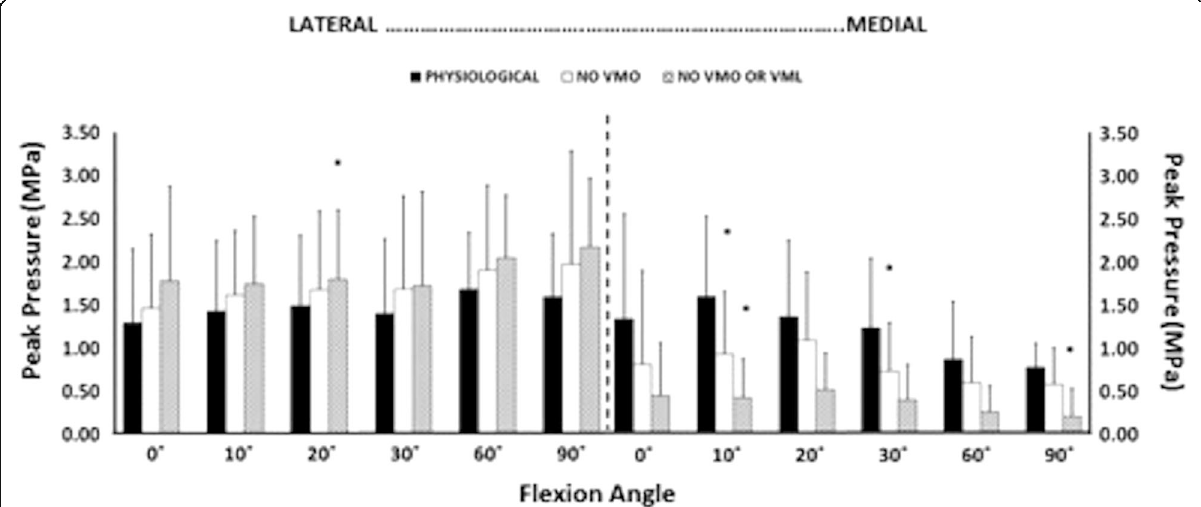
Fig. 6 Peak contact pressure on each of the meadial and lateral facets of the joint, across 0 to 90 o knee flexion, showing the effects of relaxing the VMM; * P <